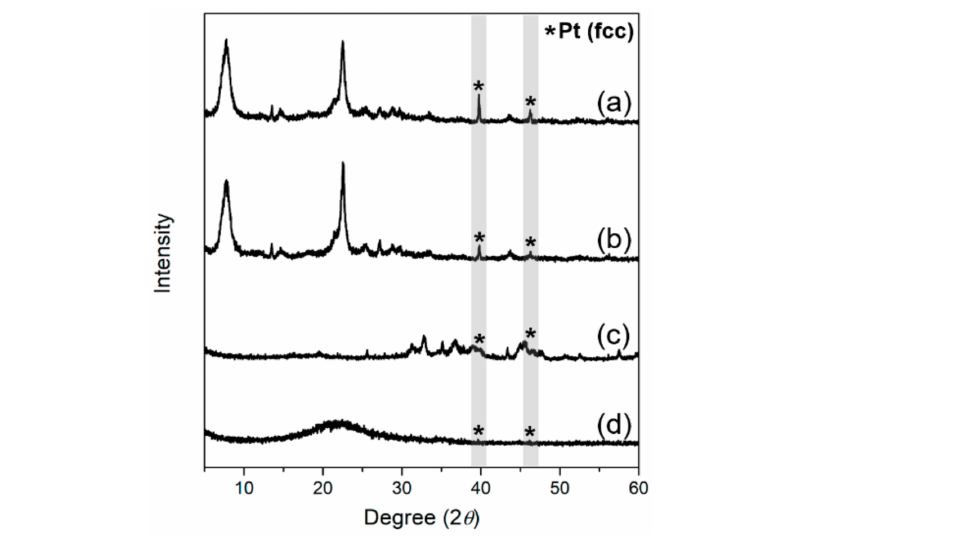
Figure 5. XRD patterns of supported Pt-Sn catalysts: ( a ) Pt-Sn/Beta(300), ( b ) Pt-Sn/Beta(38), ( c ) Pt- Sn/ θ -Al 2 O 3 , and ( d )